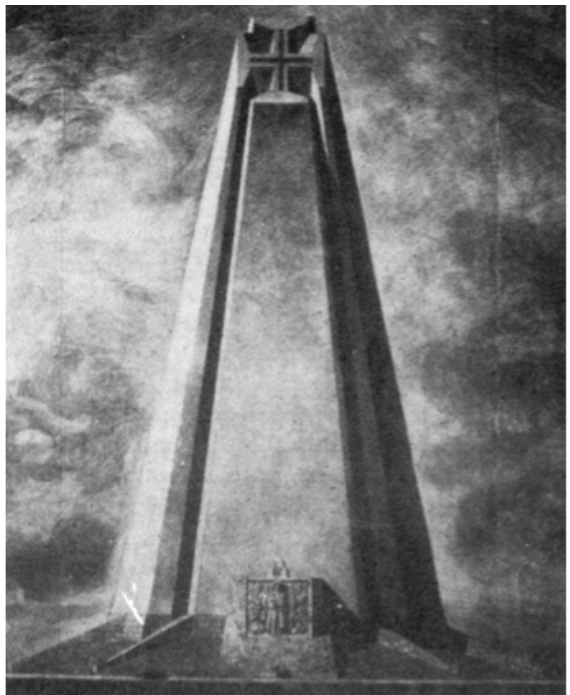
FIGURE 4 | Andrade, Gameiro, Spreading Faith, The Empire, 1933,